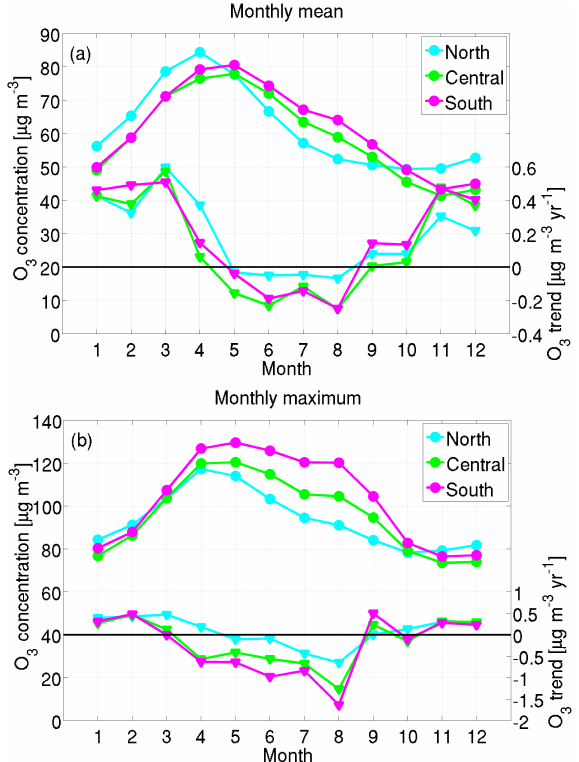
Figure 6. Seasonal cycle of monthly mean (a) and monthly max- imum (b) of 1h mean near-surface ozone concentrations averaged over the period 1990–2013 (circles; left vertical scale) and region (north, central and south Sweden; see Fig. 3) and the linear trend over the same period of the respective spatially averaged monthly values (triangles; right vertical scale). The different regions are identified by color; see legend. Results from the LONGTERM re-